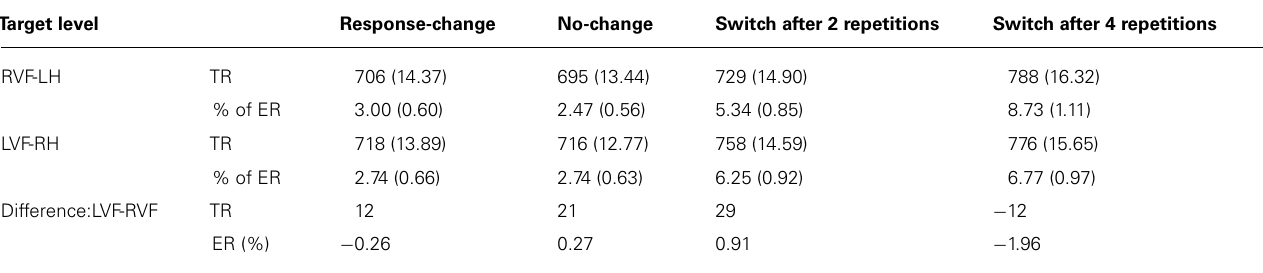
Table 2 | Mean response times in milliseconds and errors rates (standard errors in parenthesis) across context conditions.